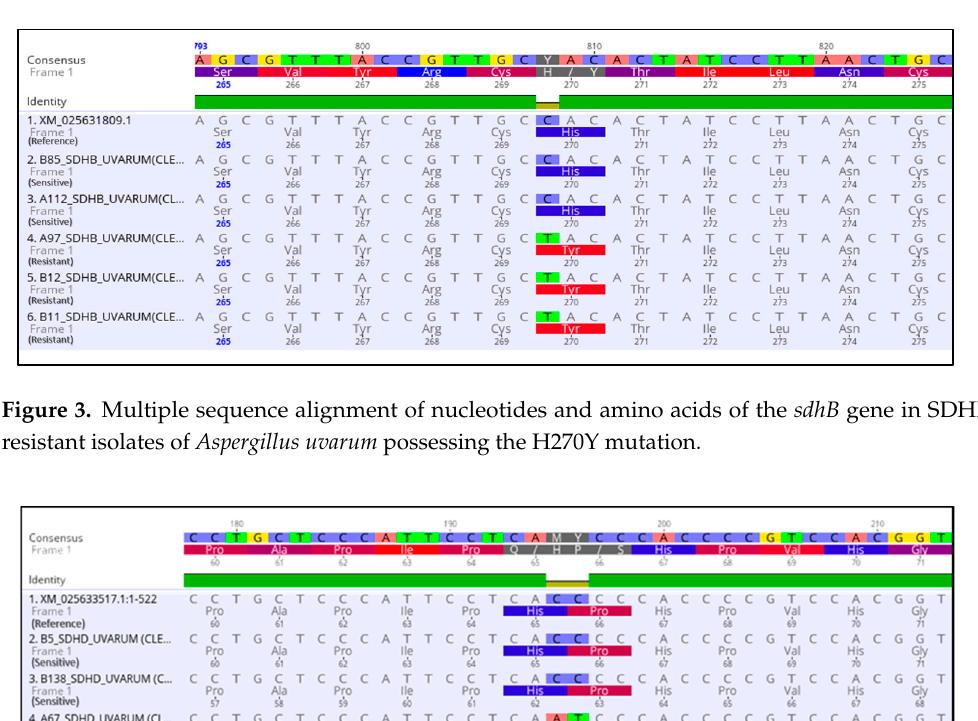
Figure 2. Frequency (%) of H270Y, H65Q/P66S, H270Y, and H65Q/P66S, and the G143A mutants of the Aspergillus uvarum population within the fluxapyroxad-resistant ( n = 42) and pyraclostrobin- resistant ( n = 16) fraction of the population.